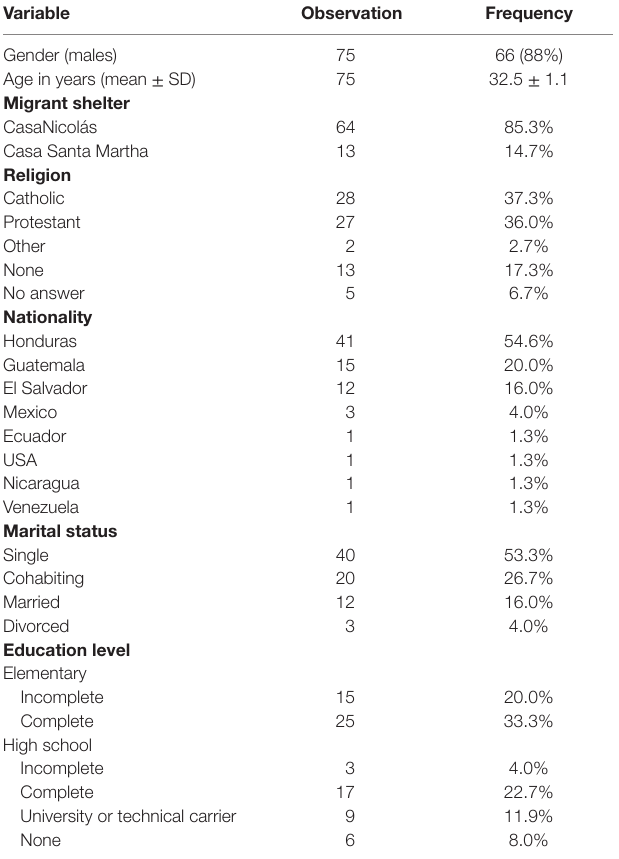
TaBle 1 | Demographic